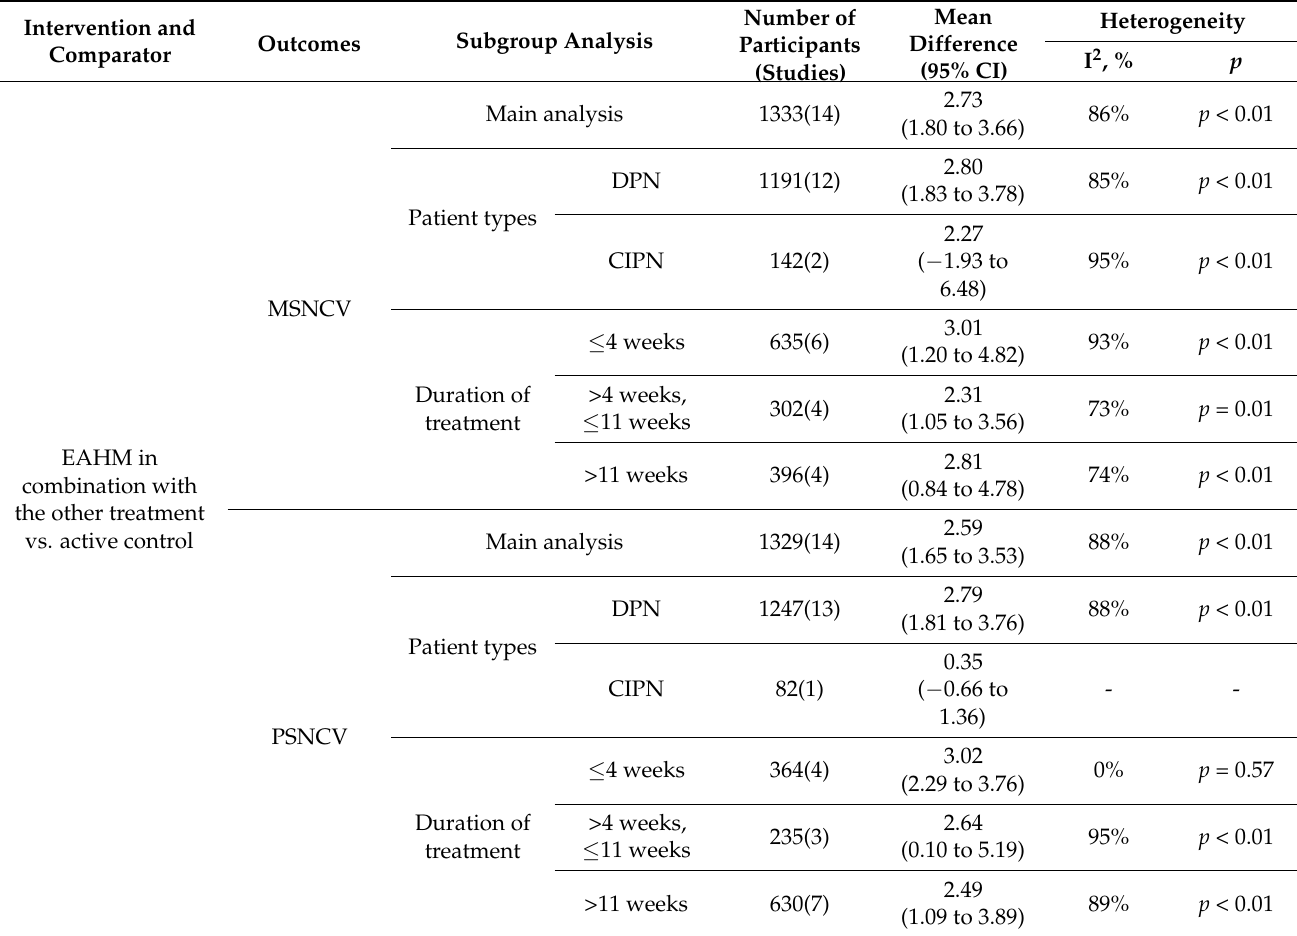
Table 3. Subgroup analysis for patient type and nerve conduction velocity